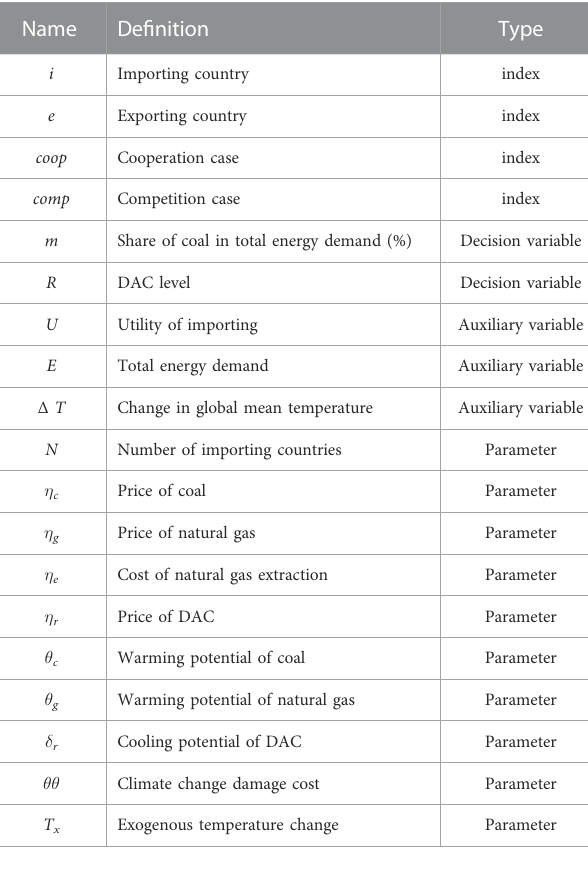
TABLE 1 List of variables and parameters used in the